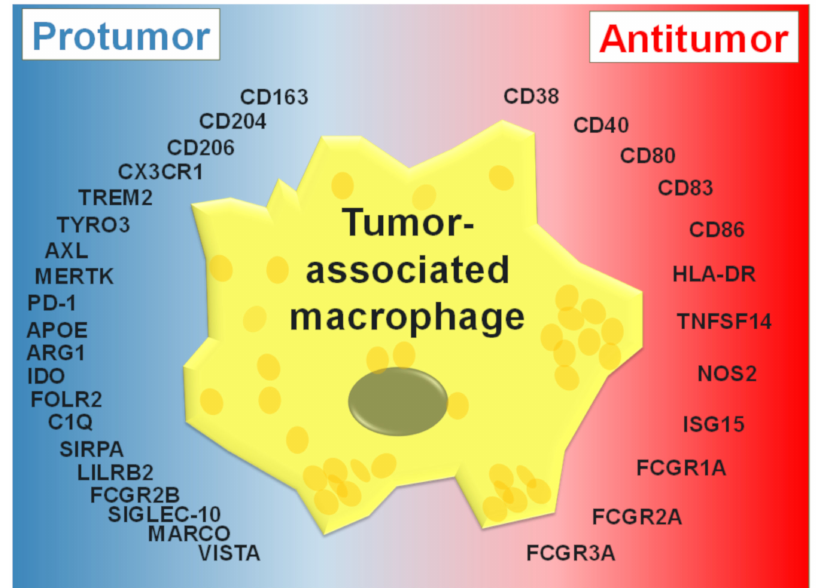
Figure 1. TAM-associated markers. Expression of genes in TAMs that phenotypically and functionally associate with protumor (blue) and antitumor (red) outcomes in the context of tumor progression and/or efficacy of direct targeting mAb therapy (adapted from